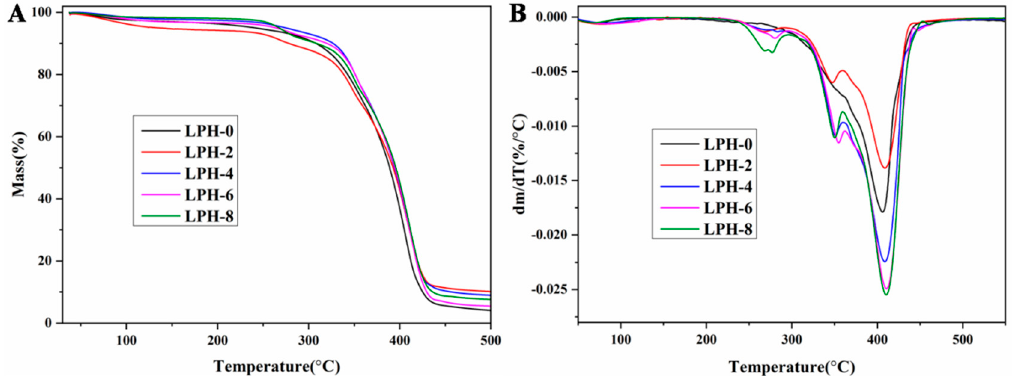
Figure 4. ( A ) TG and ( B ) DTG thermal property curves of the LPH films.